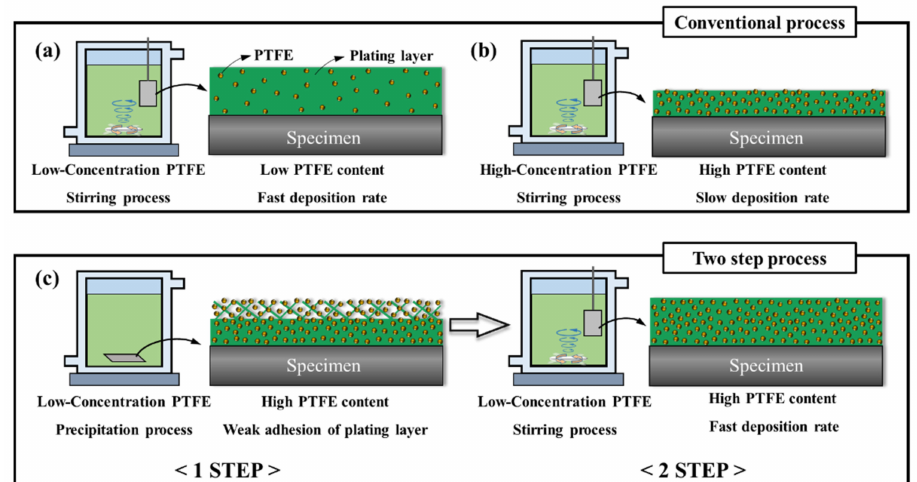
Figure 1. Electroless composite plating layers according to PTFE concentration and plating pro- cess: ( a ) plating layer using stirring process at low concentration; ( b ) plating layer using stirring process at high concentration; ( c ) plating layer obtained by combining precipitation and stirring at low